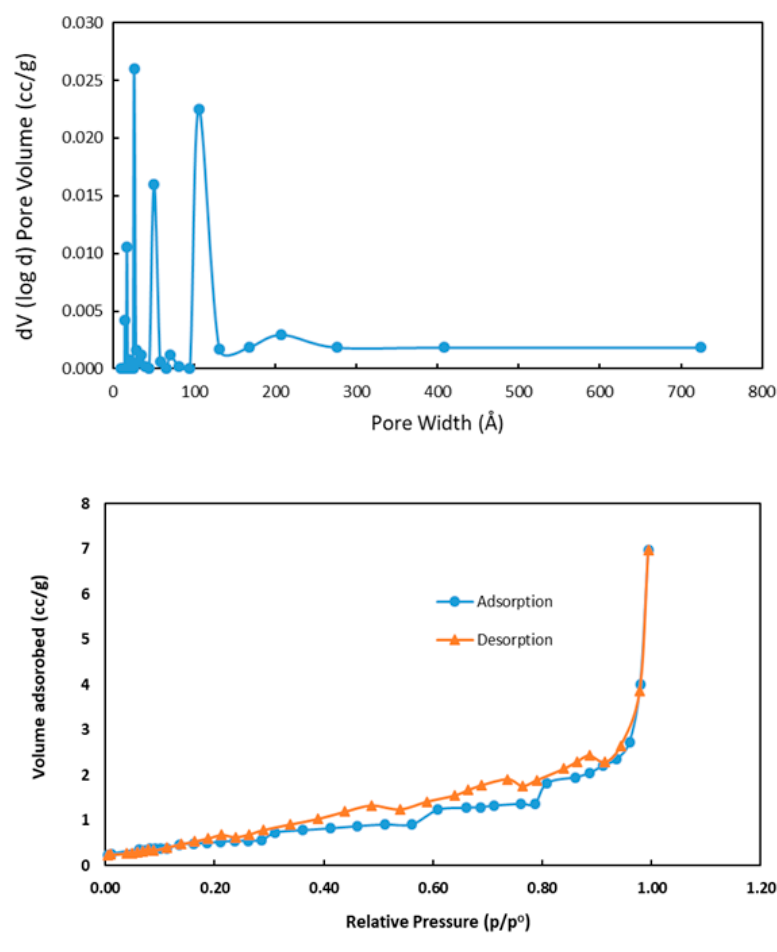
Figure 3. Pore size distribution and N2 adsorption-desorption isotherm of (CES 900 °C).